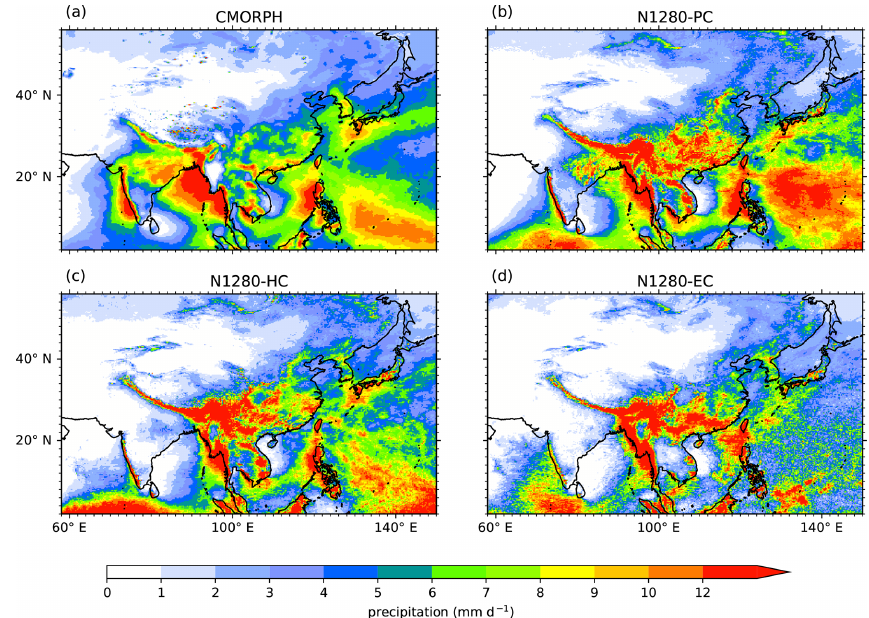
Figure 3. Mean JJA daily precipitation over Asia for CMORPH observations (a) and the parametrized (b) , hybrid (c) and explicit (d) convection simulations. The observations are taken from 1988 to 2018, and the simulations are all from 2005 to 2008. Note that in this figure we show mean precipitation, and in subsequent figures we show amount of precipitation; these two quantities are close to each other but not identical as amount of precipitation has very low values, under 0.1mmh − 1 , thresholded out (Sect.